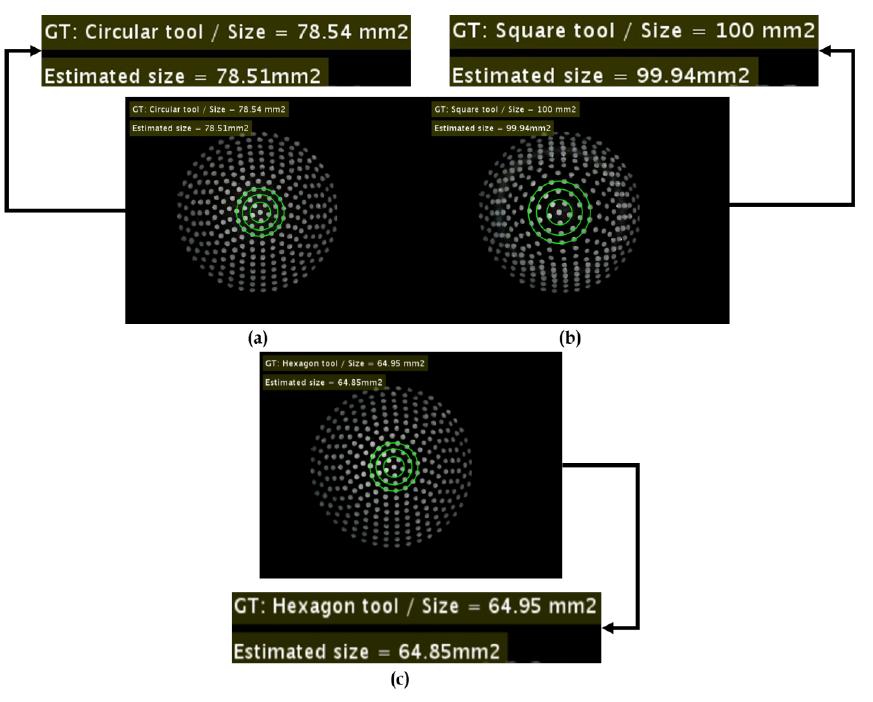
Figure 20. Estimation of 2D contact area: ( a ) Contact area estimation w.r.t circular tool. ( b ) Contact area estimation w.r.t square tool. ( c ) Contact area estimation w.r.t hexagonal